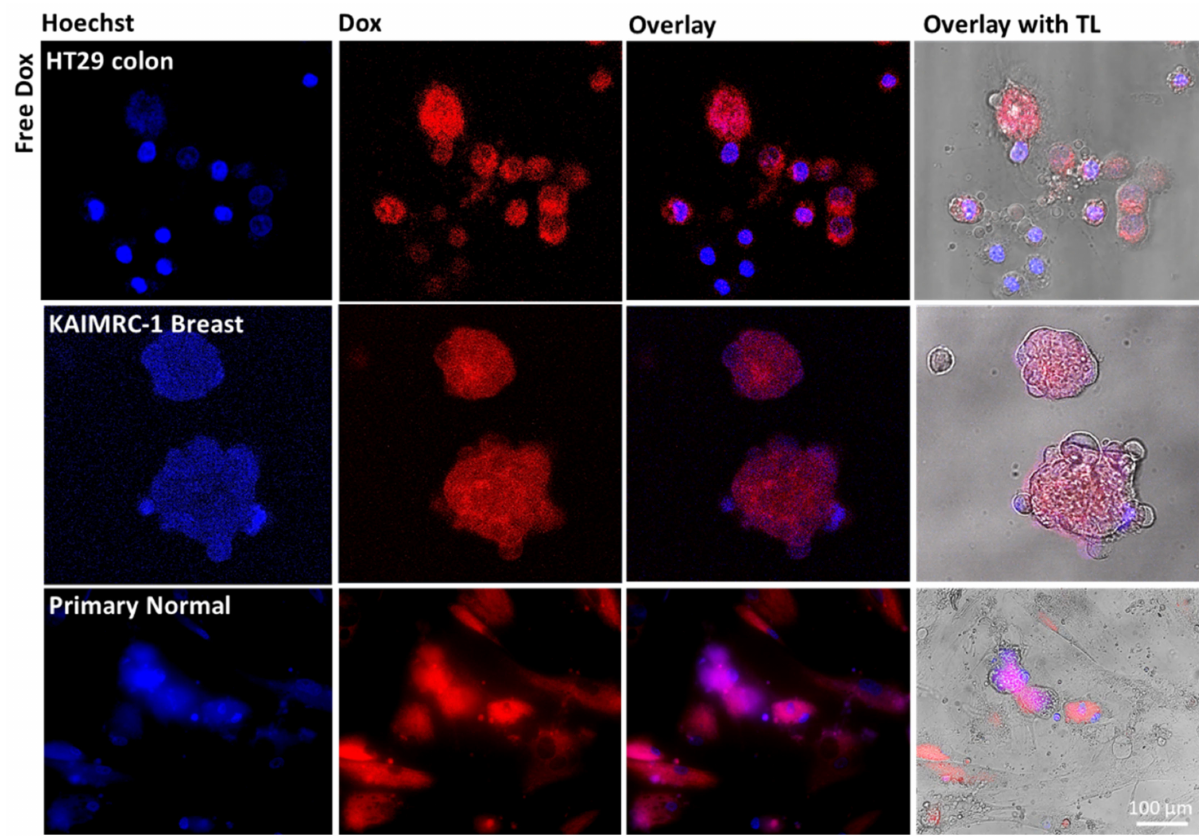
Figure 8. Live confocal microscopy images of HT-29 colon, KAIMRC-1 breast, and primary normal cells incubated with free Dox at equivalent concentration (5 µ g/mL Dox). Left to right: Hoechst nuclei stain (blue), Dox channel (red), overlay of Dox and Hoechst channels, and overlay with transmitted light (TL). The confocal images show the direct diffusal of the free drug to the nuclei of all cells, killing both the cancerous and normal